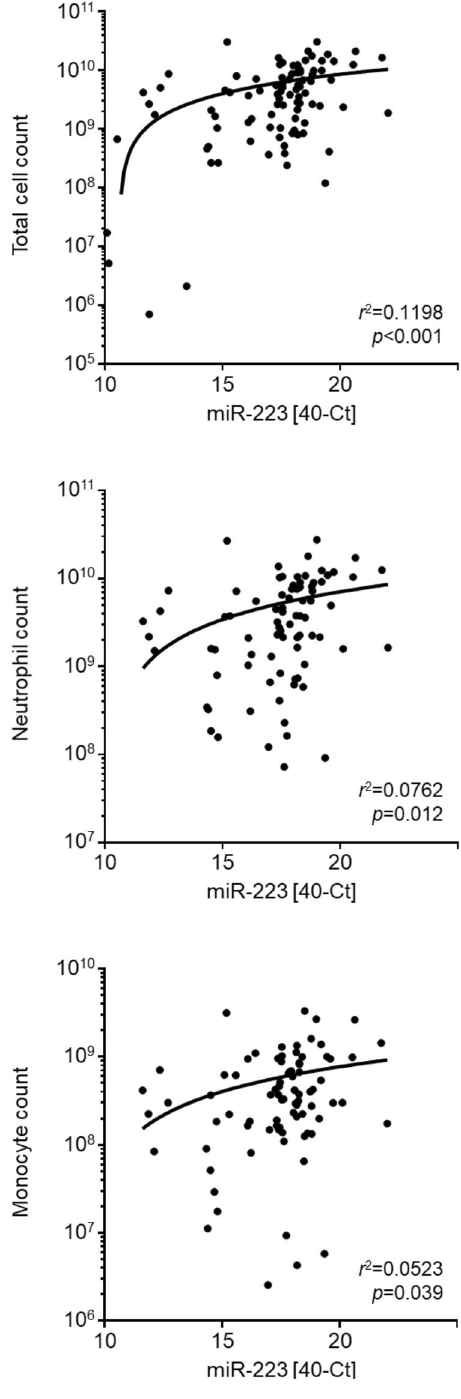
Figure 3. Correlation of peritoneal microRNAs with cellular infiltration during peritonitis. Linear regression of peritoneal miR-223 levels (40 − Ct) with cell numbers in the inflammatory infiltrate, shown as total cell count and the number of live CD14 + monocytes/macrophages or CD15 + neutrophils in effluent samples from 82 PD patients with acute